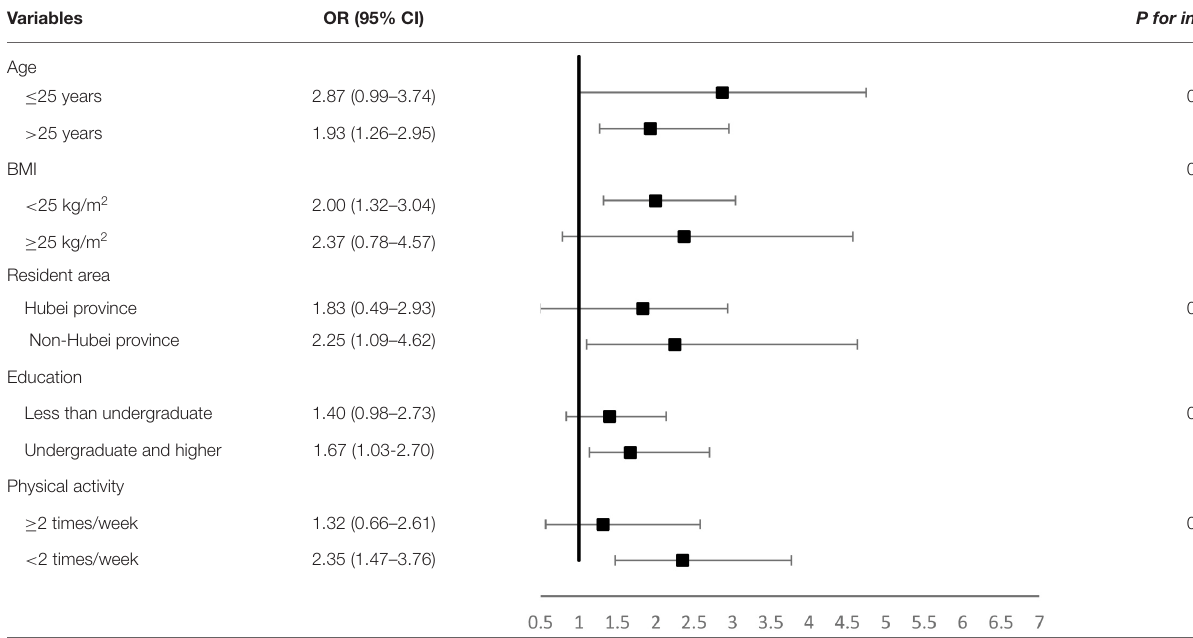
TABLE 5 | Adjusted ORs (95% CI) for anxiety in people with screen time ≥ 8 vs. ≤ 2h.